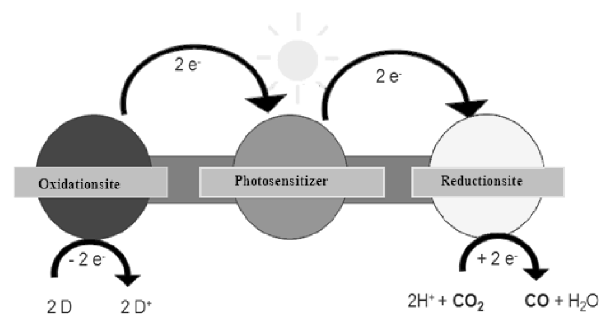
Figure 1. Building principle of homogeneous photoredox catalysts.